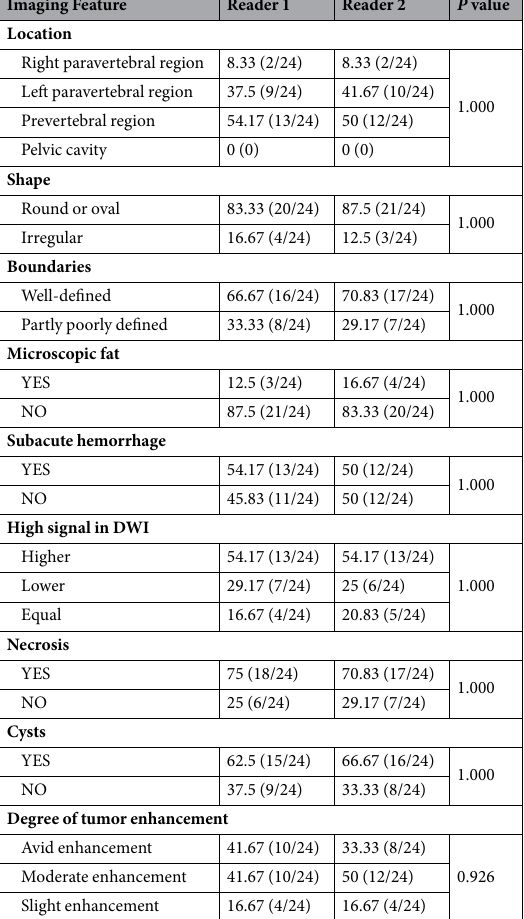
Table 3. Frequency of assessed imaging features in retroperitoneal extra-adrenal paragangliomas. Note: Data are percentages with raw numbers of patients (n) in parenthesis. P values were calculated using χ 2 tests. Higher: the high signal of the tumor in DWI is higher than that of the spleen. Lower: the high signal of the tumor in DWI is lower than that of the spleen. Equal: the high signal of the tumor in DWI is equivalent to that of the spleen.